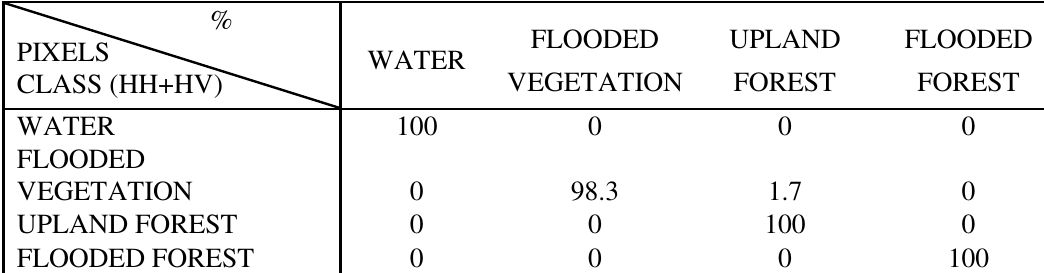
Table 3. Confusion matrix for USTC classification of the different surface cover types